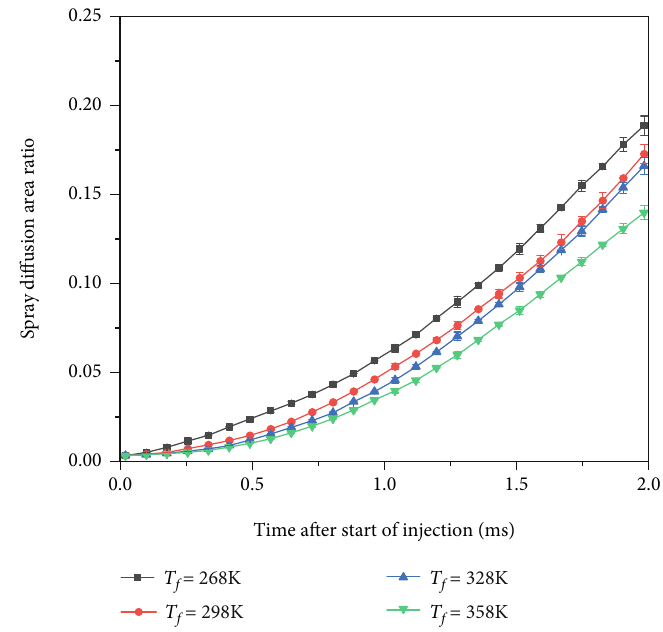
= 0 : 8MPa , Δ T = 4 : 0 ms f f